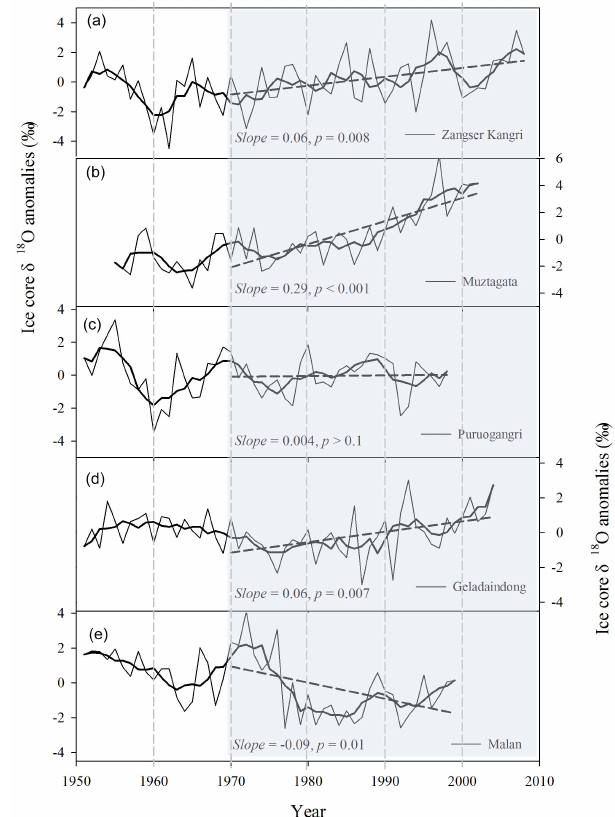
Figure 3. Comparisons of the anomalies of δ 18 O records in the ZK ice core (a) with δ 18 O records from Muztagata (b) , Puruogangri (c) , Geladaindong (d) , and Malan ice cores (e) . Thin lines represent an- nual values, thick lines the 5-year running averages, and the dashed lines the linear trends since